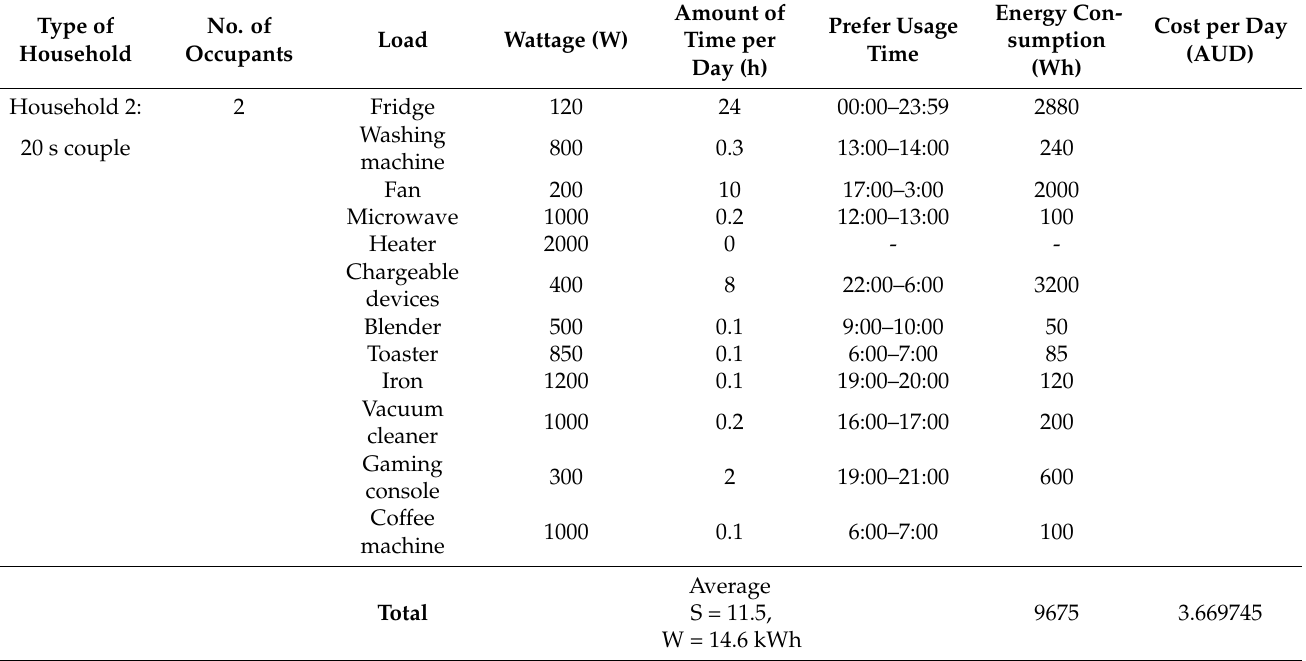
Table 4. Initial load profile 2 created for the project